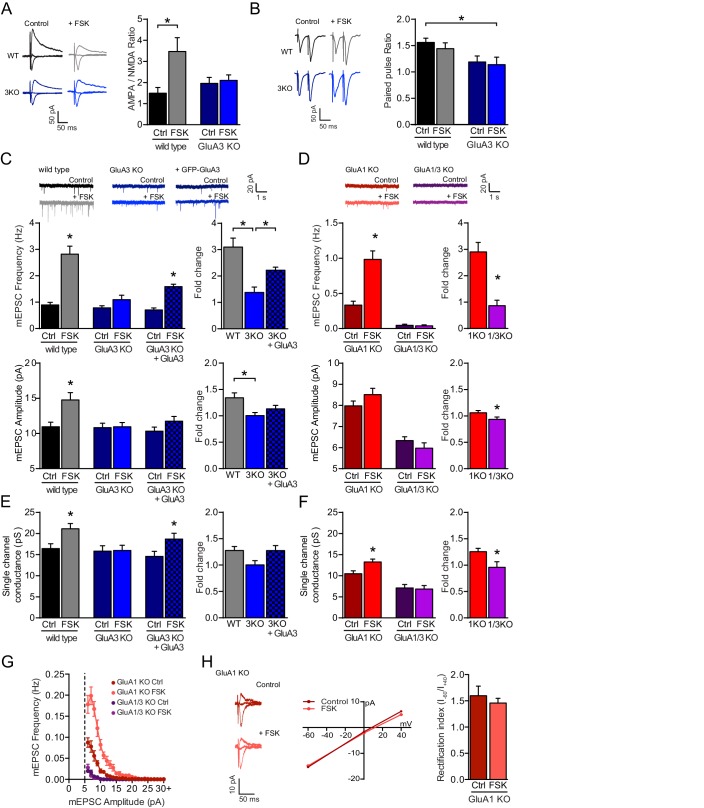
The cAMP-driven postsynaptic potentiation depends on GluA3.(A) Example traces and average AMPA/NMDA EPSC ratios of WT neurons with (grey; n=13) or without (black; n=9) forskolin, and GluA3-KO neurons with (blue; n=8) or without (dark blue; n=8) forskolin. In WT neurons the AMPA/NMDA ratio increased upon forskolin incubation (ANOVA, p=0.02), but not in GluA3-KO neurons (ANOVA, p>0.9). (B) Example traces and average paired pulsed ratio, which were not different in WT CA1 neurons with (n=8) or without (n=8) forskolin (ANOVA: p=0.9), or of GluA3-KO neurons with (n=8) or without (n=8) forskolin (ANOVA: p>0.9). (C) In WT neurons mEPSC frequencies (t-test, p<0.0001) and amplitudes (t-test, p=0.001) were higher in presence (n=16) versus absence (n=15) of forskolin. In GluA3-KO CA1 the mEPSC frequency (t-test, p=0.15) and amplitude (t-test, p=0.9) were not different in presence (n=9) or absence (n=8) of forskolin. In Sindbis-infected GluA3-KO neurons expressing GFP-GluA3 (blocked bars) the mEPSC frequency (t-test, p<0.0001), but not amplitude (t-test, p=0.1), increased in presence (n=11) versus absence (n=8) of forskolin. The forskolin-driven fold increase in mEPSC frequency (ANOVA, p<0.0001) and amplitude (ANOVA, p=0.006) was higher in WT versus GluA3-KO neurons. This fold increase in GFP-GluA3 infected versus uninfected GluA3-KO neurons was larger in mEPSC frequency (ANOVA, p=0.007), but not amplitude (ANOVA, p=0.4). (D) Forskolin increased mEPSC frequencies (t-test, p<0.0001) and amplitudes (t-test, p=0.15) of GluA1-KO neurons (ctrl: dark red; n=11; FSK: light red; n=10), but not in GluA1/3-KO neurons (ctrl: dark purple; n=11; FSK: light purple; n=8). The forskolin-driven fold increase in mEPSC frequency (t-test, p<0.0001) and amplitude (t-test, p=0.03) was larger in GluA1-KO versus GluA1/3-KO. (E) Non-stationary noise analysis of scaled mEPSCs revealed single-channel conductance of WT neurons with (n=10) or without (n=13) forskolin (t-test, p=0.009), GluA3-KO neurons with (n=8) or without (n=8) forskolin (t-test, p=0.9), and GFP-GluA3-expressing GluA3-KO neurons with (n=11) or without (n=8) forskolin (t-test, p=0.03), and forskolin-driven fold increase in single-channel conductance (WT vs GluA3-KO: ANOVA, p=0.07; GluA3-KO uninf. vs GFP-GluA3-inf: ANOVA, p=0.07). (F) Non-stationary noise analysis of scaled mEPSCs revealed single-channel conductance of GluA1-KO neurons with (n=8) or without (n=12) forskolin (t-test, p=0.01) and GluA1/3-KO neurons with (n=6) or without (n=11) forskolin (t-test, p=0.9), and forskolin-driven fold increase in single-channel conductance (t-test, p=0.02). (G) mEPSC distribution per 1 pA binned amplitude of GluA1-KO neurons without (dark red; n=11) or with (light red; n=10) forskolin and GluA1/3-KO neurons without (dark purple; n=11) or with (light purple; n=8) forskolin. (H) GluA3 exists as GluA2/3 heteromeric AMPARs. Example traces with corresponding I-V curve and average rectification indices ((I-60mV – I0mV) / (I+40mV – I0mV)) were determined in GluA1-KO organotypic slices of CA1 neurons without (n=6) or with (n=6) forskolin treatment (t-test, p=0.7). Error bars indicate SEM, * indicates p<0.05.